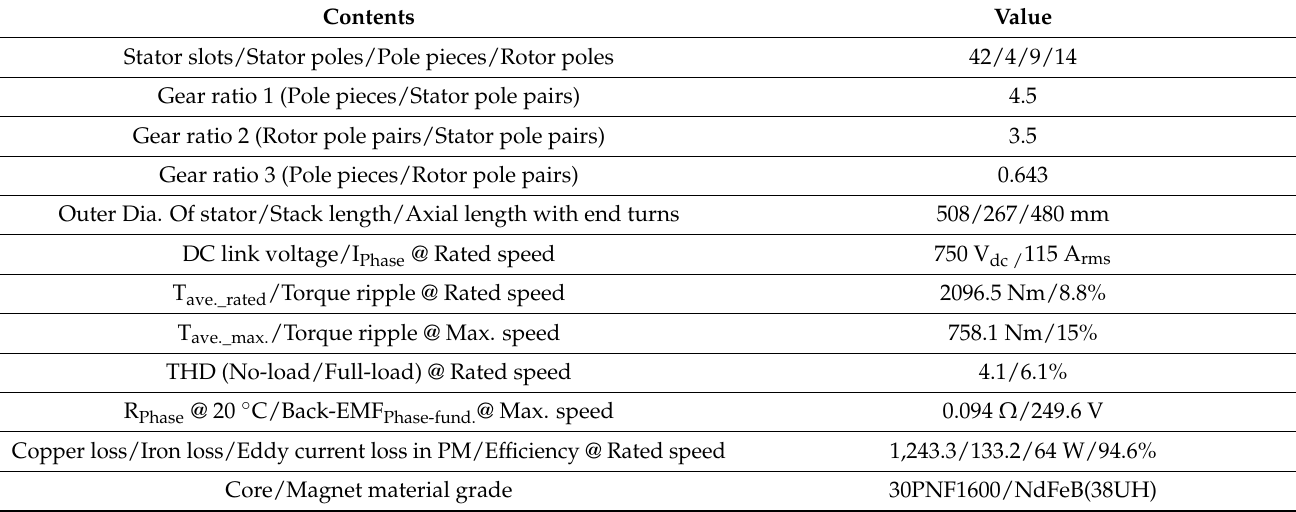
Table 3. Specifications of 45kW-class MG-PMSM Design Model with Distributed